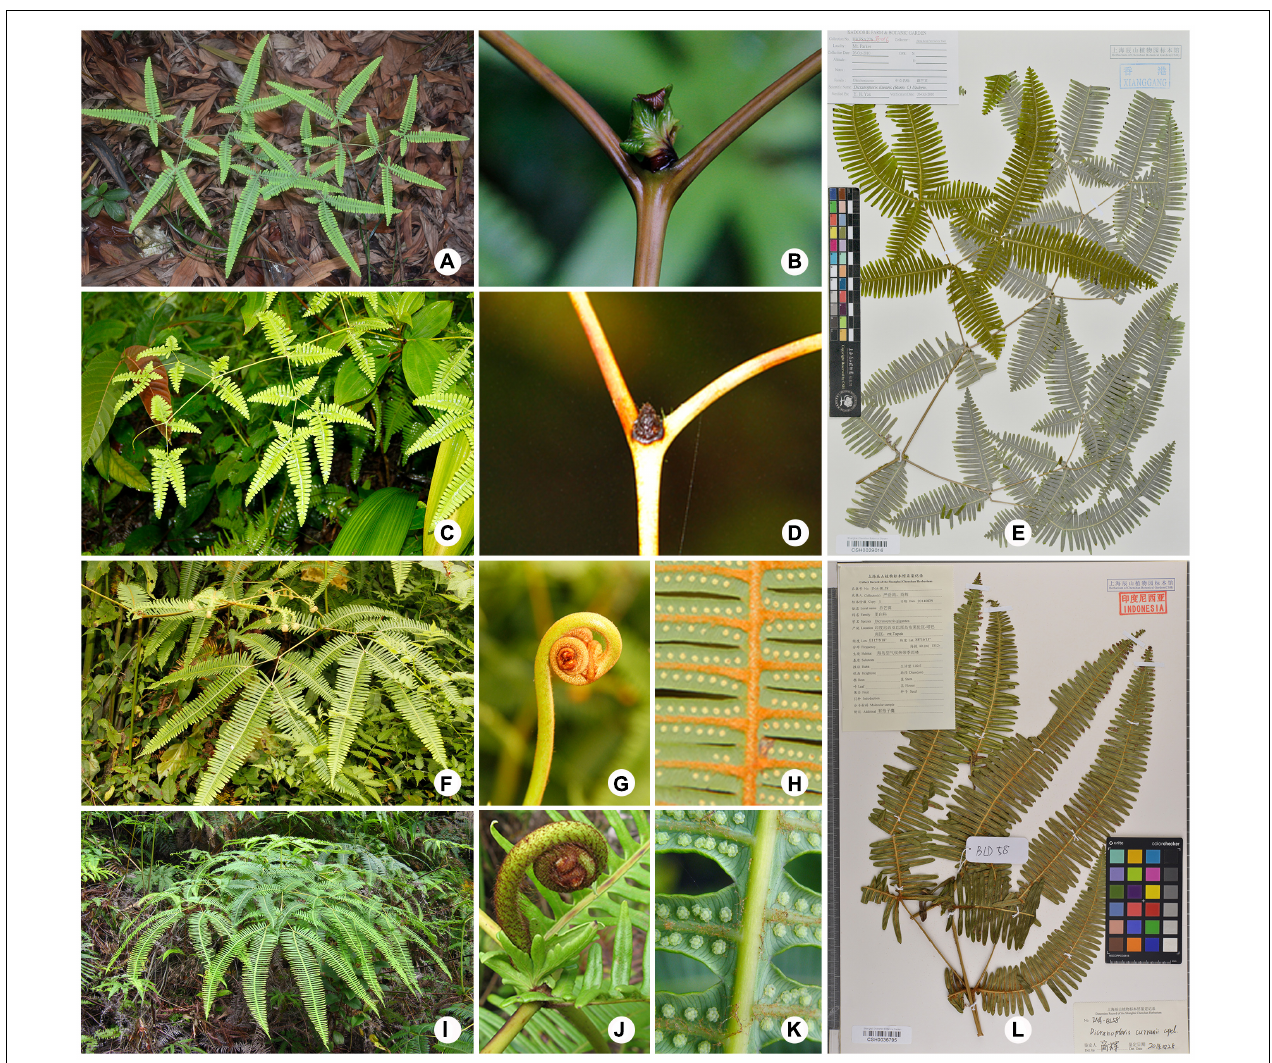
FIGURE 4 | It showing two new species and similar species. (A) D. austrosinensis sp. nov. (B) The main fork of D. austrosinensis sp. nov. showing a latend bud with stipule-like pseudostipules. (C) D. taiwanensis . (D) The main fork of D. taiwanensis showing sterile bud. (E) The type specimen of D. austrosinensis sp. nov. (F) D. baliensis sp. nov. (G) Crozier of D. baliensis sp. nov. with red–brown scales. (H) Lower surface of costae and costules of D. baliensis sp. nov. with rather persistent hairs. (I) D. curranii . (J) Crozier of D. curranii with atrocastaneous scales. (K) Lower surface of costae and costules of D. curranii with deciduous hairs. (L) The type specimen of D. baliensis sp.